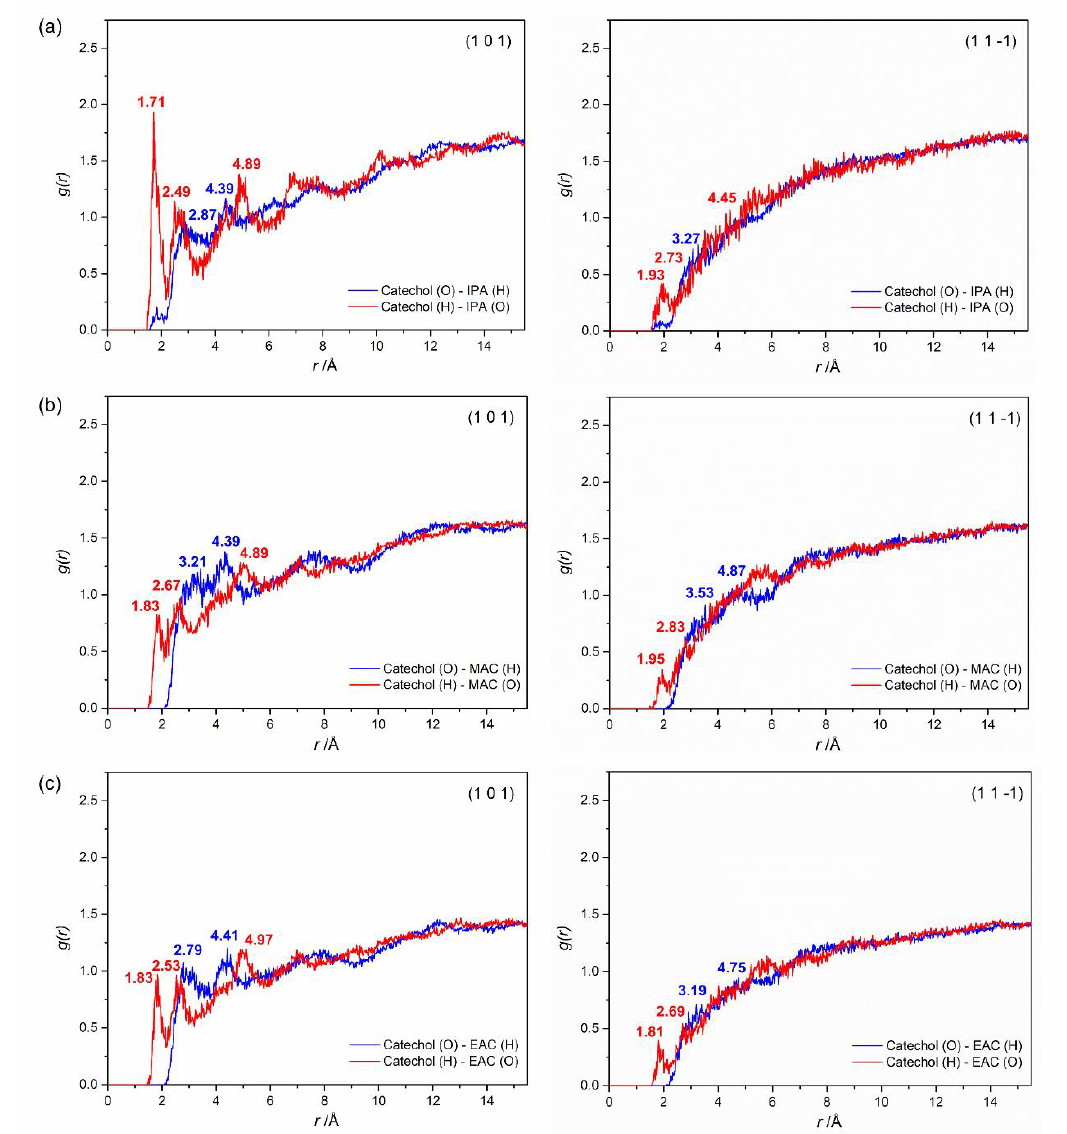
Figure 8. The radial distribution function (RDF) analysis between catechol and ( a ) isopropanol, ( b ) methyl acetate, ( c ) ethyl acetate molecules on the (1 0 1) face (left) and the (1 1 − 1) face (right).